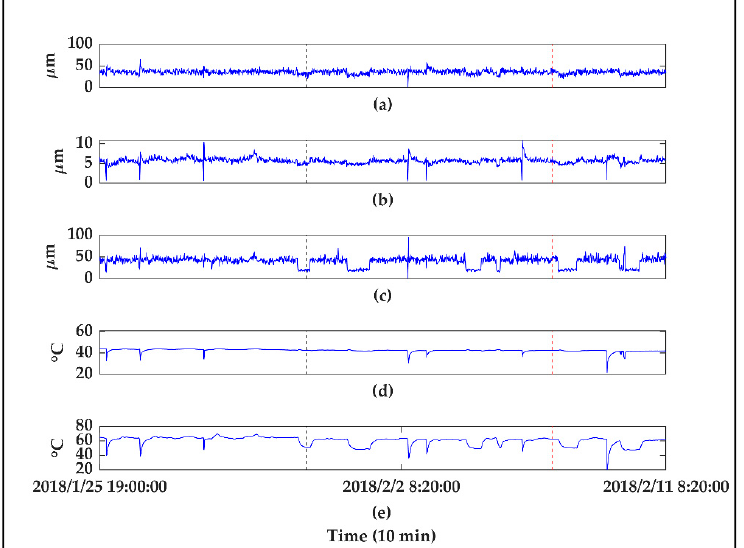
Figure 10. The changing curve of correlation monitoring parameters of hydropower units in case 2: ( a ) vibration of oil receiver in the Y direction, ( b ) vibration of combined bearing in the Y direction, ( c ) vibration of water guide bearing in the Y direction, ( d ) temperature of forwarding thrust bearing bush, ( e ) temperature of the stator core.